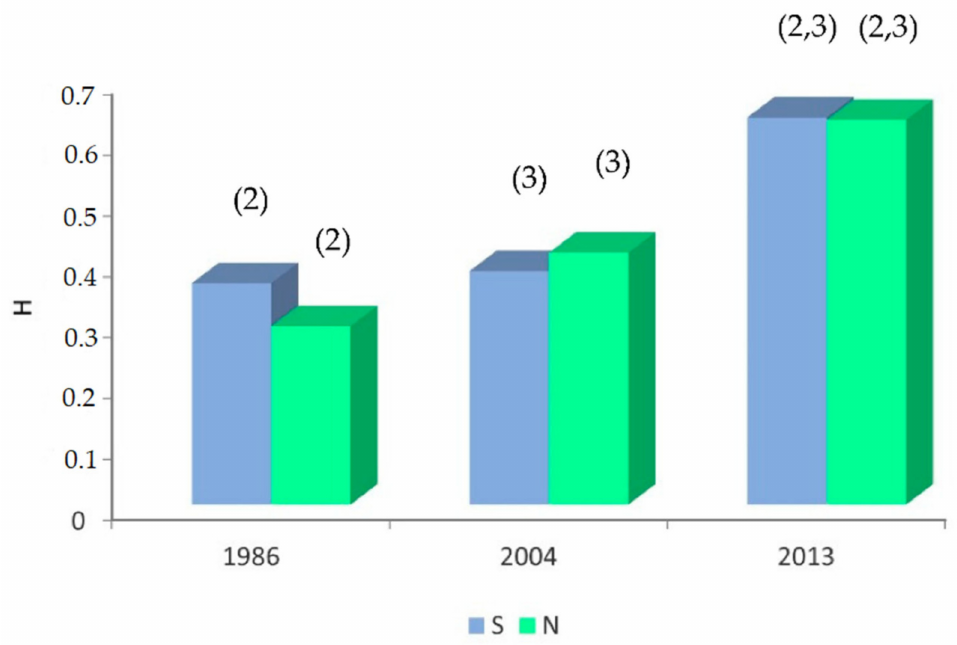
Figure 6. Temporal variability of the Shannon–Wiener index (H) based on rotifer abundance in Lake Kortowskie (S–the site in the southern basin of the lake, where the pipeline is located; N–the site in the northern basin of the lake). The significance of differences ( p < 0.05) between years were indicated as follows: (2)–the difference between 1986/2013; (3)–the difference between 2004/2013. The differences between sites in the years analyzed were insignificant ( p > 0.05).